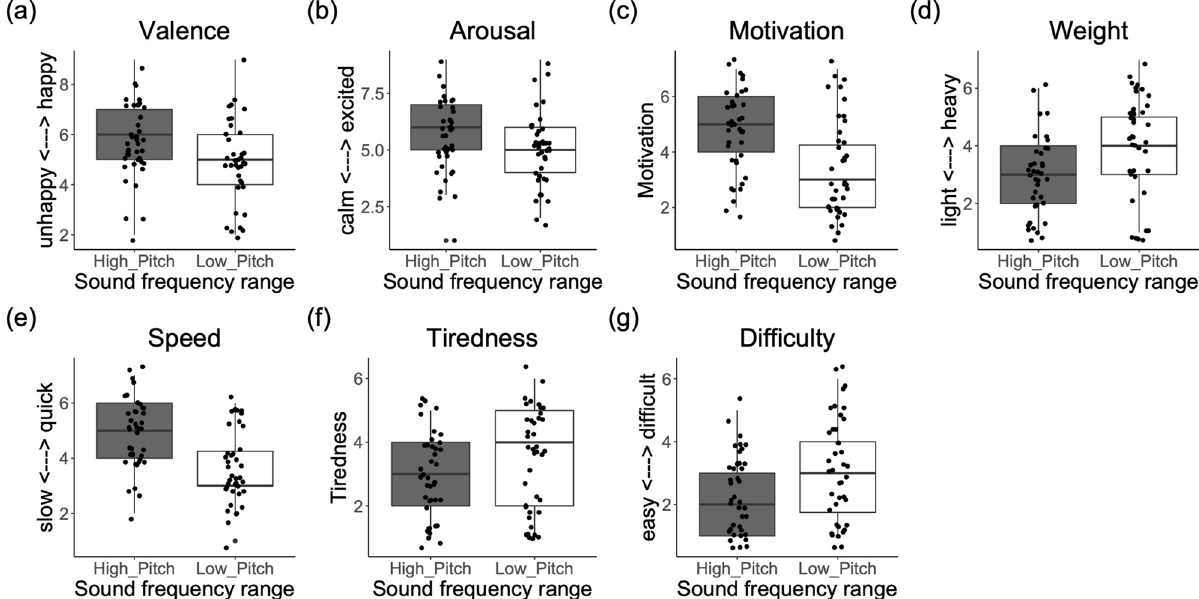
Figure 5. Boxplots with median (range) score for questionnaire items showing significant effects of Sound Frequency Range in Experiment 3 . ( a ) Emotional valence (happiness), ( b ) arousal (excitation) and ( c ) motivation; ( d ) feelings of body weight, ( e ) speed, and ( f ) tiredness; and ( g ) movement